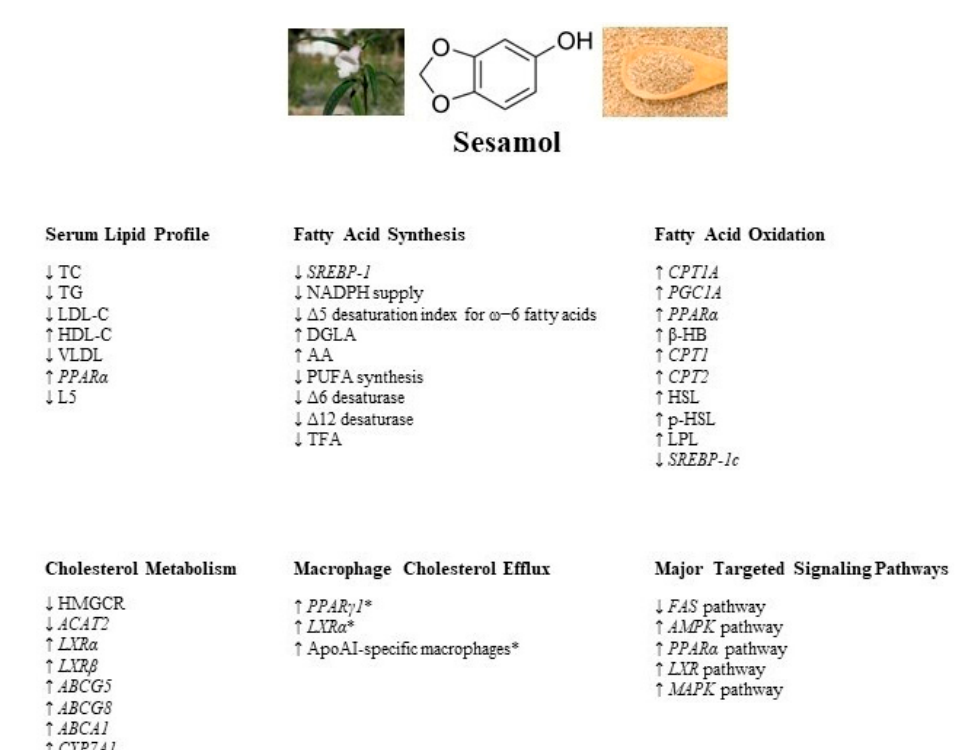
Figure 1. A summary of the regulatory effects of sesamol on serum lipid profile and signaling factors and proteins involved in fatty acid synthesis, fatty acid oxidation, cholesterol metabolism, and macrophage cholesterol homeostasis. The major signaling pathways targeted by sesamol are denoted as well. (* with the addition of sesame oil). TC: total cholesterol; TG: triglyceride; LDL-C: low-density lipoprotein cholesterol; HDL: high-density lipoprotein cholesterol; VLDL: very low-